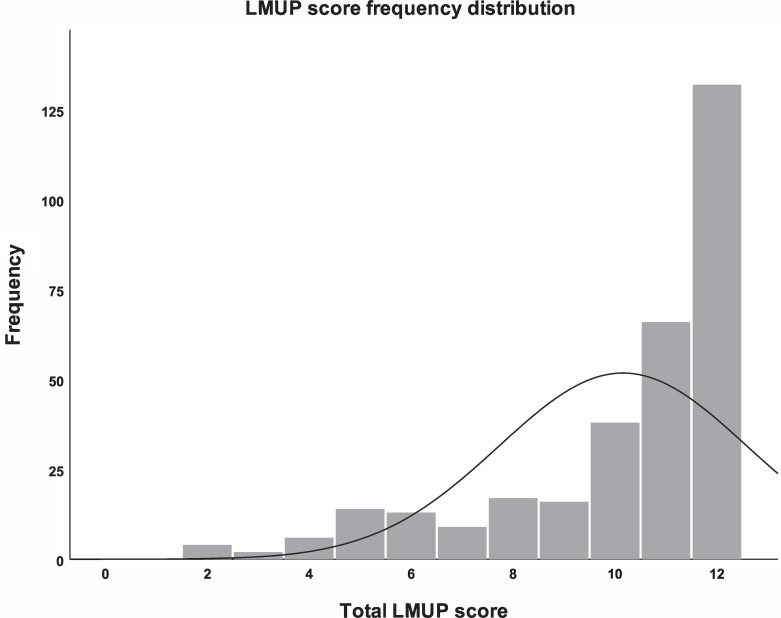
Distribution of LMUP scores.